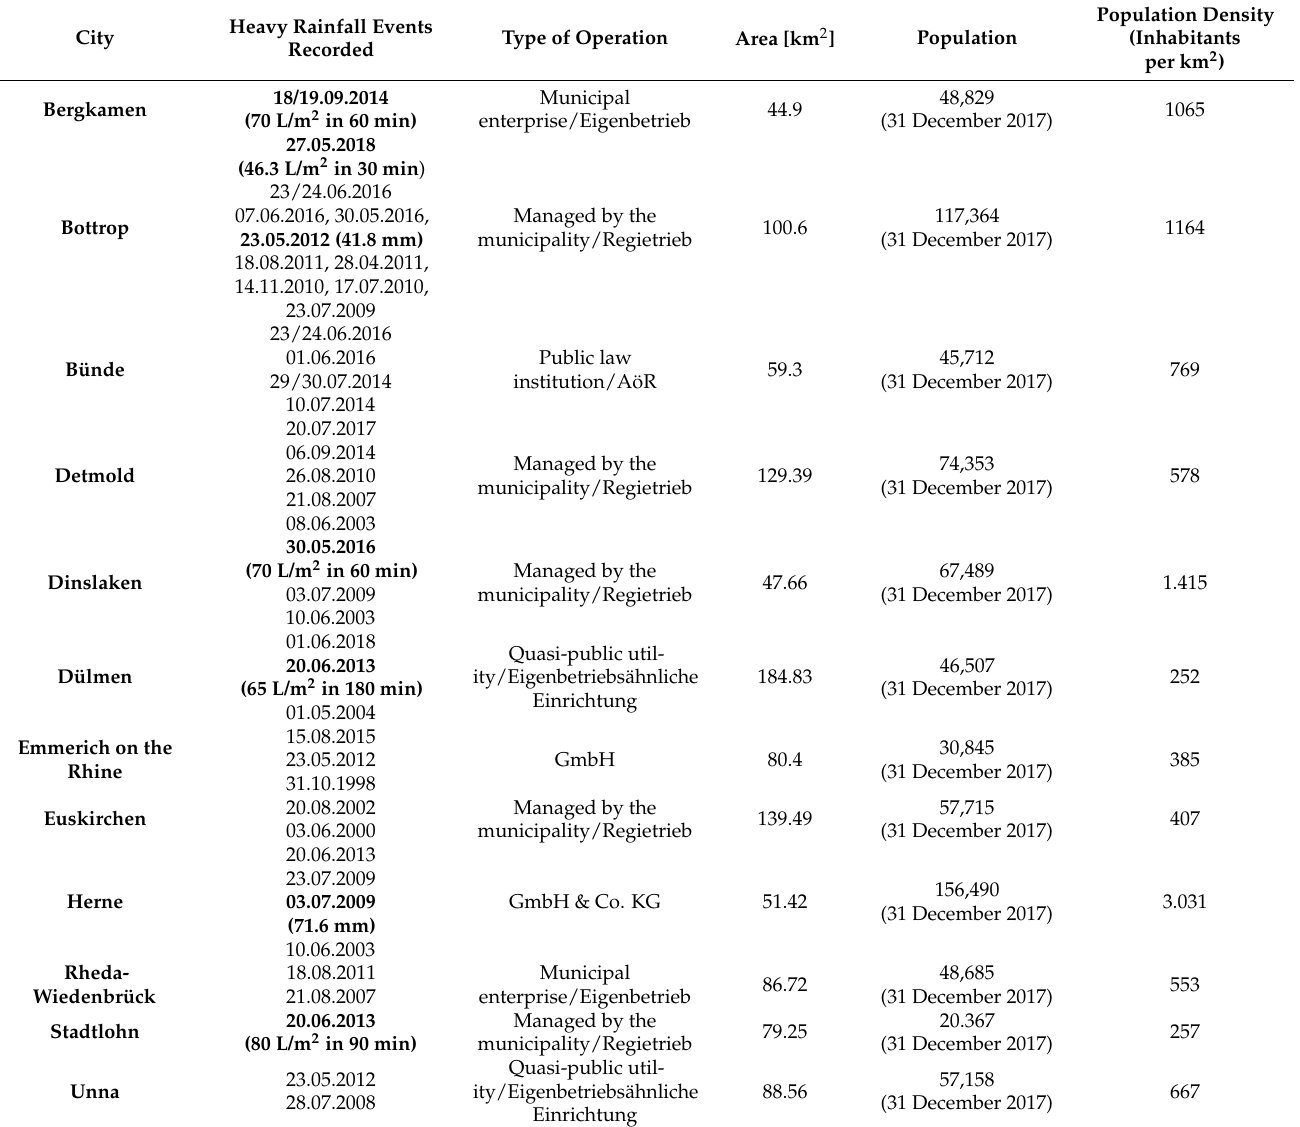
Table 1. Municipal members of the expert panel dealing with rainfall during recent years. Heavy Rainfall Events City Type of Operation Area [km 2 Recorded